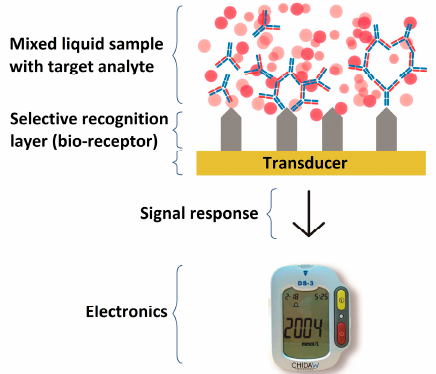
Figure 1. General scheme of a biosensor detection strategy. A biosensor is composed of a biochemical interface where specific bio-species are recognized; a transducer which translates the recognition event to another physical response that can be measured and an electronic system which acquires and records the signal.